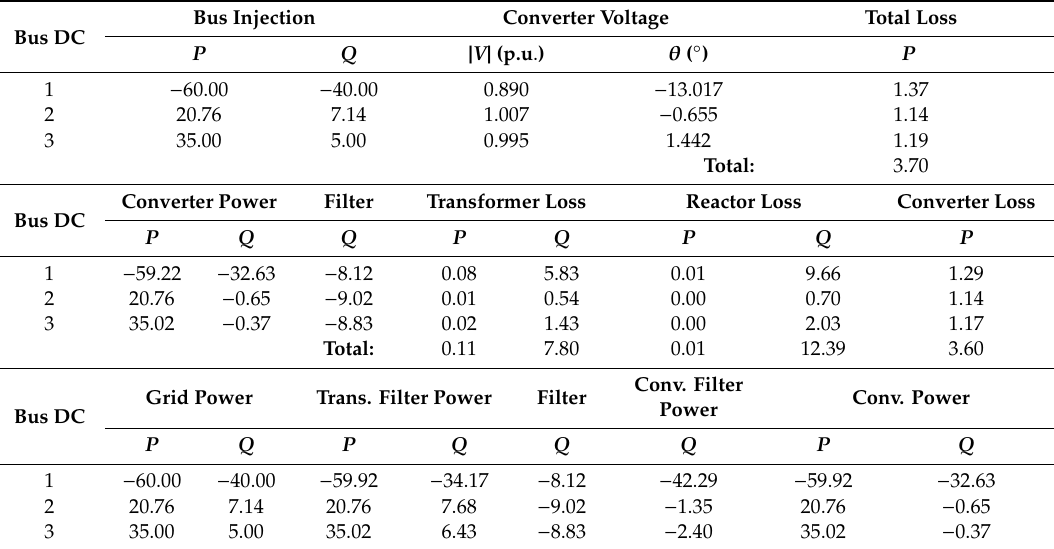
Table A6. Results of the mixed AC / DC PF calculations in Case 2. Converter station data.